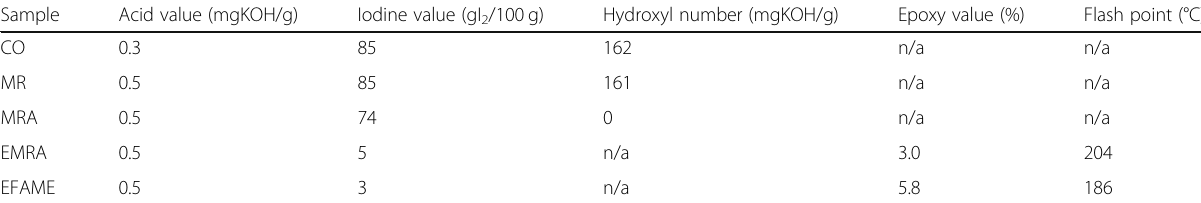
Table 1 Physicochemical parameters of EMRA and corresponding intermediates